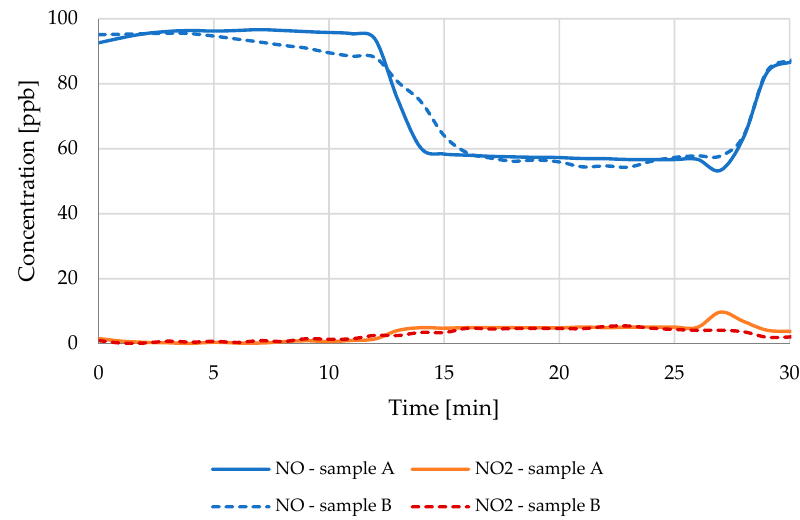
Figure 7. Concentration of NO x over time (cleaned sample, 300 W light source).